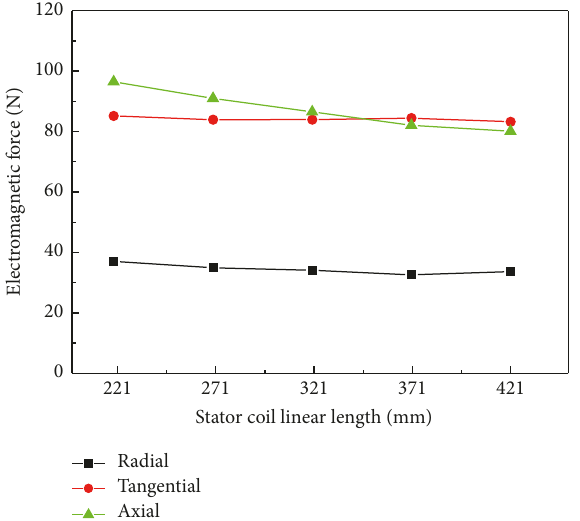
Figure 18: Electromagnetic forces on the nose part with different stator coil linear